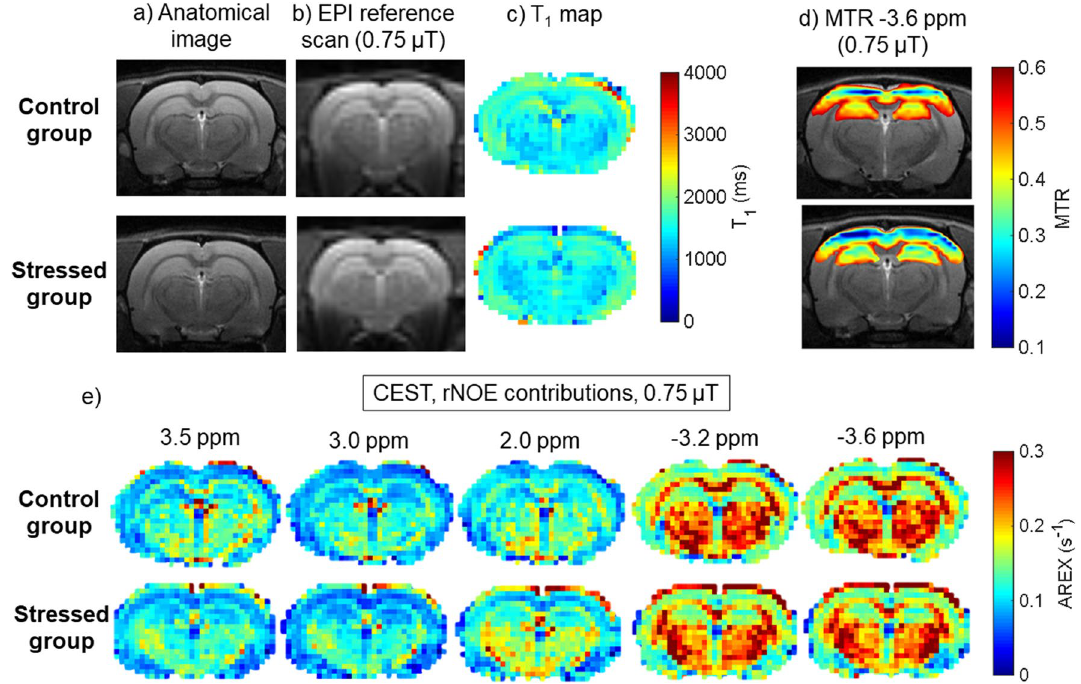
Figure 4. Images from the representative animals from control (first row) and stressed (second row) groups containing ( a ) anatomical T 2 -weighted RARE image, ( b ) EPI reference scan (B 1 of 0.75 µT) ( c ) calculated T 1 maps, ( d ) MTR maps with a saturation B 1 of 0.75 µT at an aliphatic frequency offset (− 3.6 ppm) and ( e ) CEST and rNOE contribution maps covering whole brain area at all offsets of interest and B 1 of 0.75 µT.